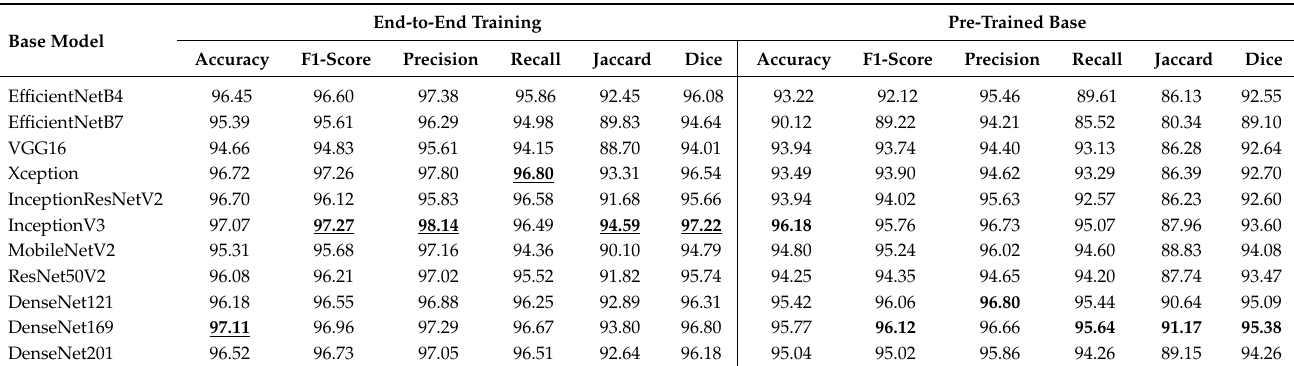
Table 3. Classification performance (%) of the examined deep neural network architectures following Approach 2 when using the pretrained weights for the base network and when training each network end-to-end.